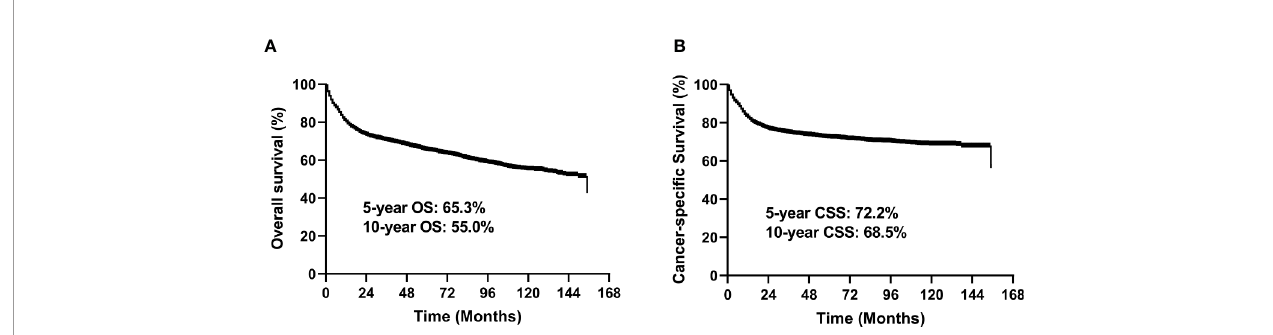
FIGURE 2 | Kaplan-Meier survival curves for OS (A) and CSS (B) for all TABLE 2 | Univariable and multivariable analyses of cancer-speci fi c survival in the training cohort. Variables Cancer-speci fi c survival Multivariate analysis